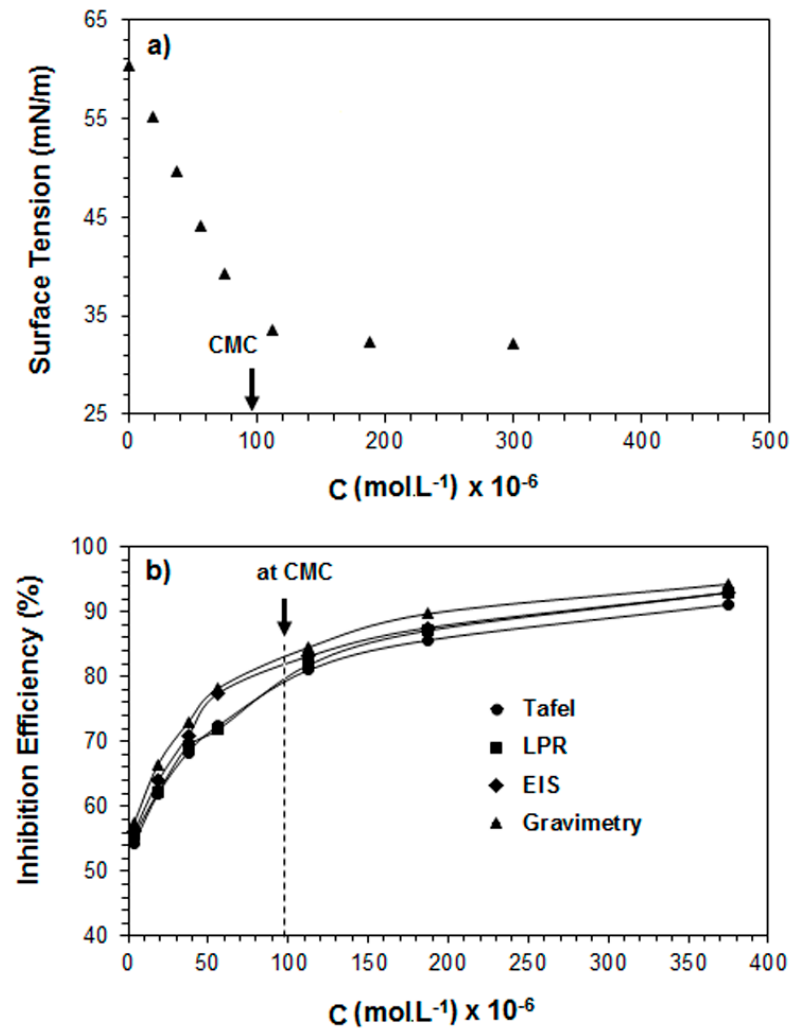
Figure 8. ( a ) Surface tension versus concentration, and ( b ) inhibition efficiency versus concentrations of corrosion inhibitor 7 in 1 M HCl at 333 K.